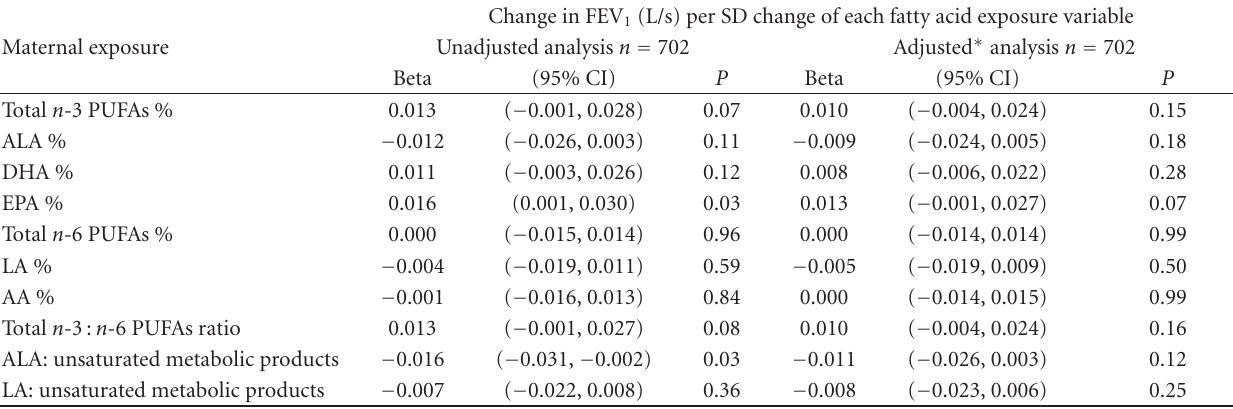
Table 7: Regression coe ffi cients for the association between standardised values ( z -scores) of maternal plasma PC fatty acids and FEV 1 at 6 years of